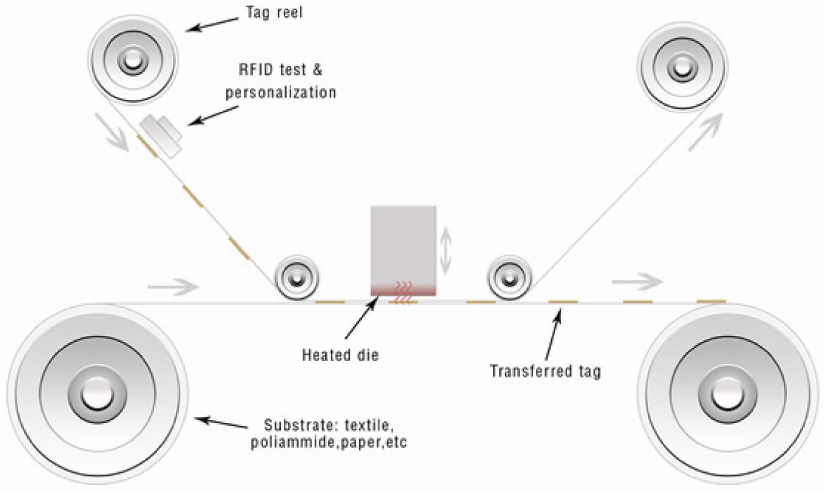
Figure 5. The Smartres s.p.a. inlay-less RFID